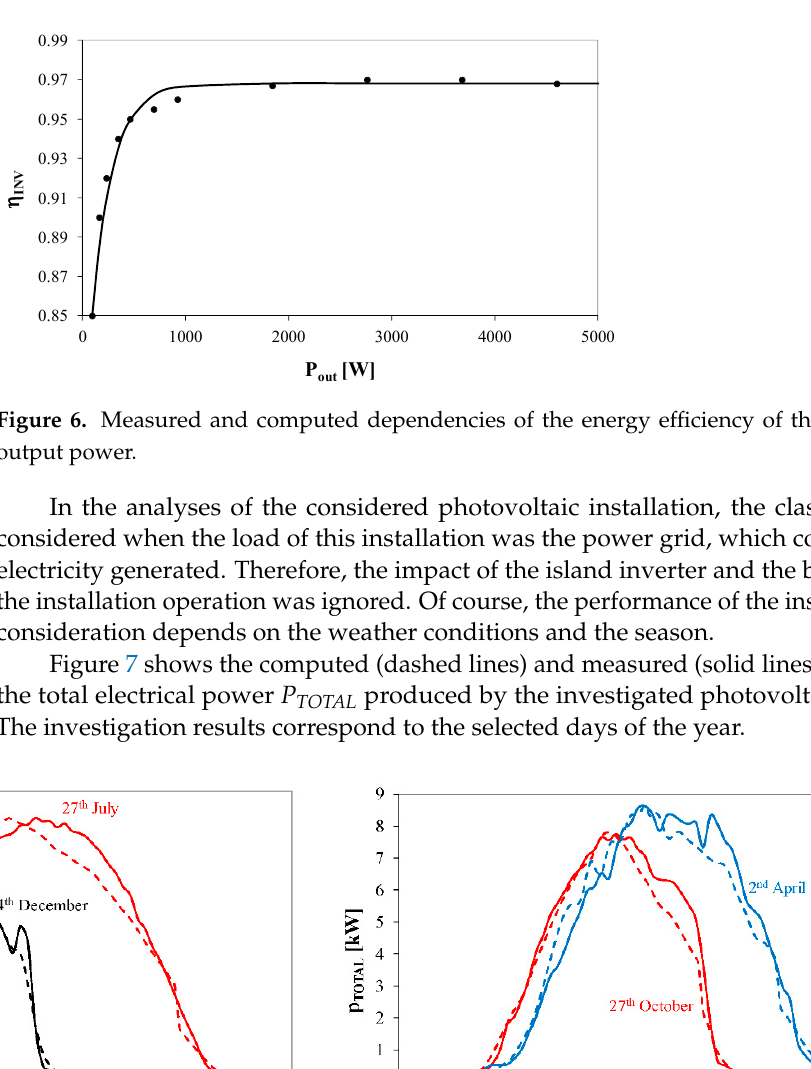
Figure 7. Measured and computed waveforms of the power produced by the investigated photovoltaic installation on selected days .